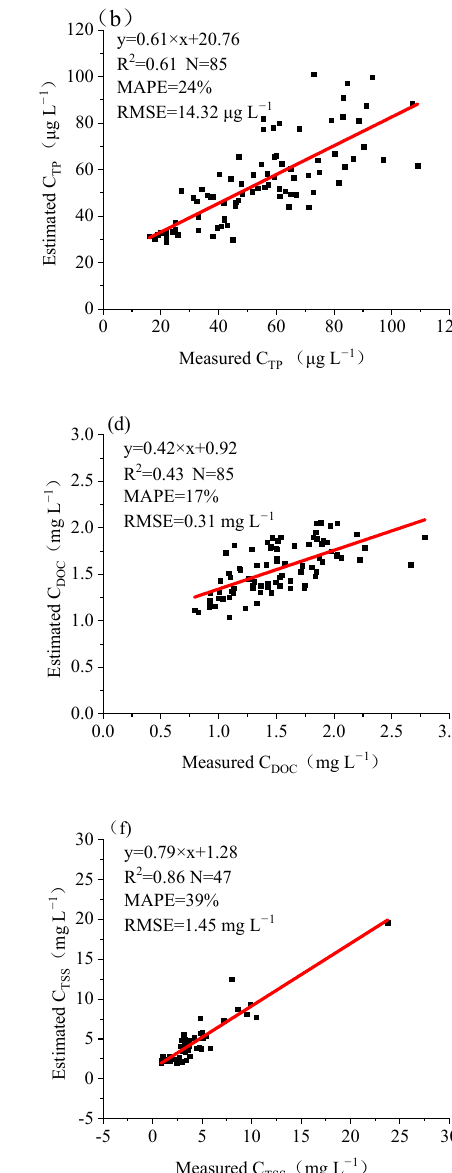
Figure 2. Scatter plots show the water quality parameters between the measurements and estimated values by regression equations. ( a ) TN; ( b ) TP; ( c ) NO 3 -N; ( d ) DOC; ( e ) Chl a ; ( f ) TSS.